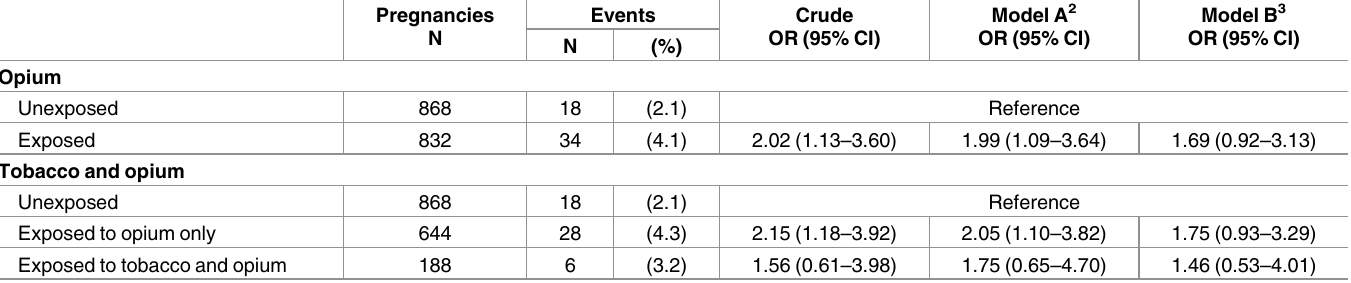
Table 4. Odds ratios (OR) and 95% confidence intervals (CI) for association between opium and tobacco use during pregnancy and risk of caesar- ean section preterm delivery 1